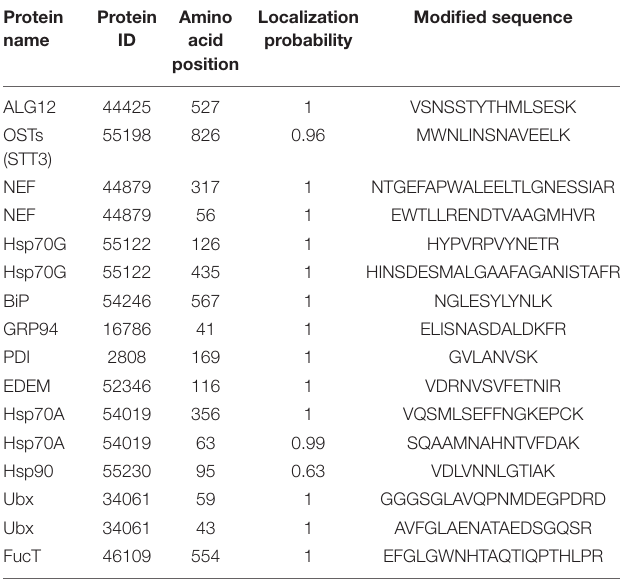
TABLE 2 | The detailed information of N-glycoproteins during the protein N-glycosylation